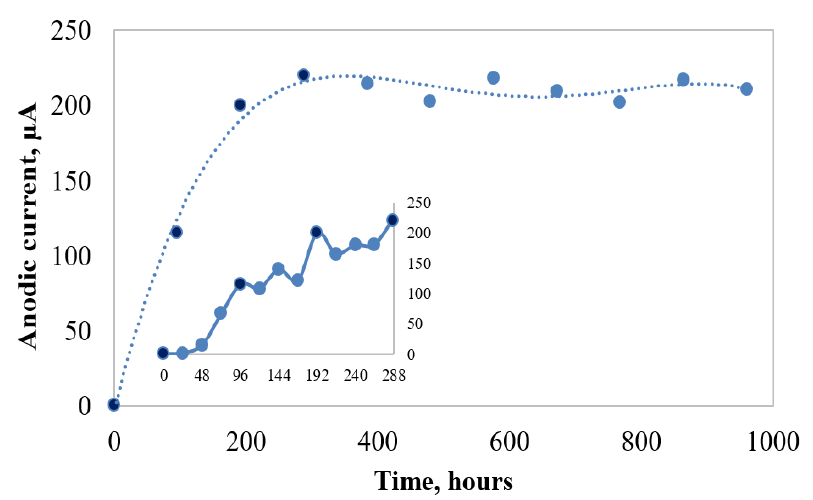
Figure 2. Biofilm development expressed as anodic current measured by cyclic voltammetry.